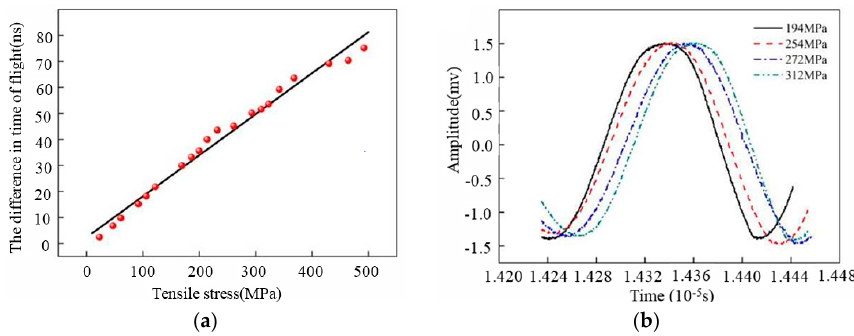
Figure 8. ( a ) Acoustic elastic curve of Rayleigh waves in aluminum alloy; ( b ) Rayleigh wave signals in aluminum alloy under different stress.